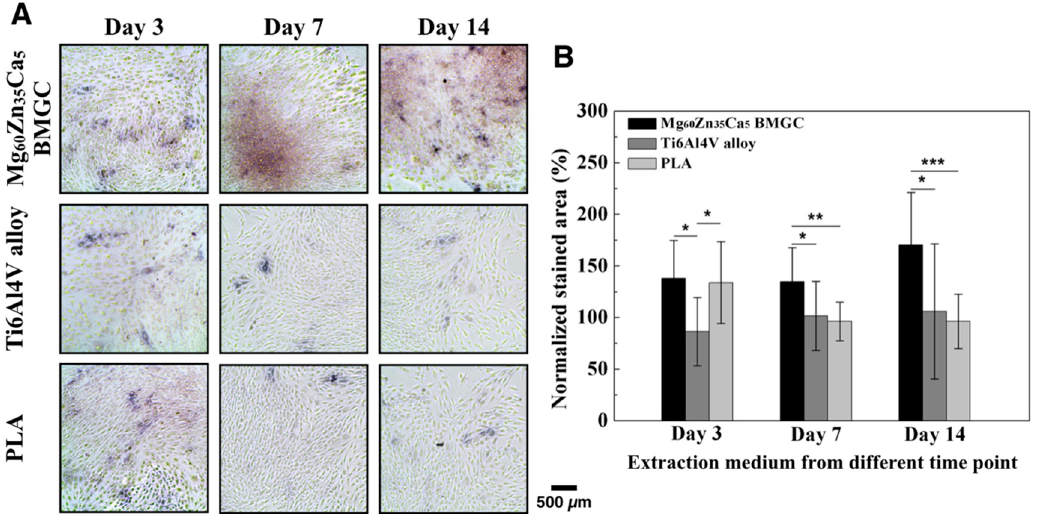
Figure 2. Alkaline phosphatase (ALP) activity of primary rabbit osteoblasts under treatment with different extraction medium. ( A ) Image of ALP staining. ( B ) Quantitation of ALP of primary rabbit osteoblasts cultured in different extraction medium for different time periods. (Data normalized with control group: without extraction medium; * p < 0.05, ** p < 0.01, *** p < 0.001.)